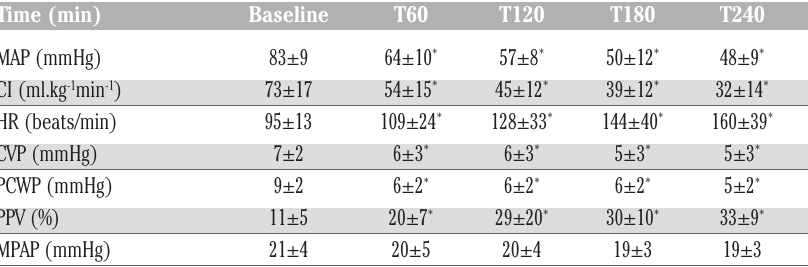
Figure 3. Ileal mucosal and muscularis microcirculatory blood flow (MBF) changes dur- ing peritonitis. Peritonitis was induced at TB (baseline). MBF were set at 100% at TB. Values at 60, 120, 180 and 240 (T240=onset of septic shock) min were expressed as per- centage of their baseline values. Data are presented as mean±SD. * P <0.05 (different from baseline). Table 1. Hemodynamic data during peritonitis. TB, baseline value before induction of peritonitis. Values were taken at 60, 120, 180 and 240 (onset of septic shock) min after induction of peritonitis; MAP, mean arterial pressure; CI, cardiac index; HR, heart rate; CVP, central venous pressure; PCWP, pulmonary capillary wedge pressure; VPP, pulse pressure variation; MPAP, mean pulmonary artery